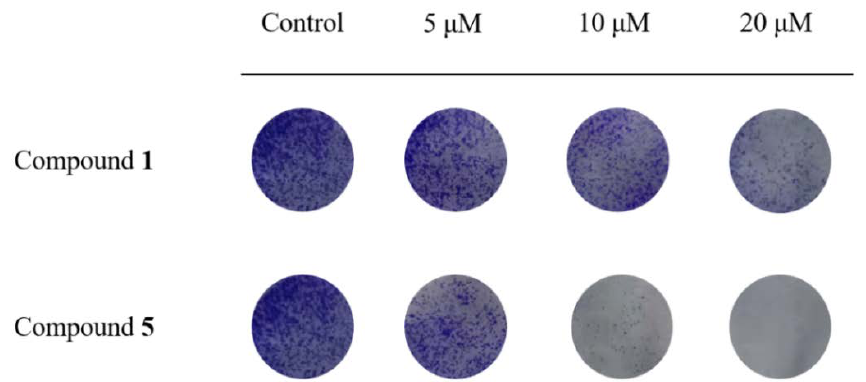
Figure 5. The effects of compounds 1 and 5 on RKO cell clones after 7 days of treatment with 5, 10 and 20 μM.